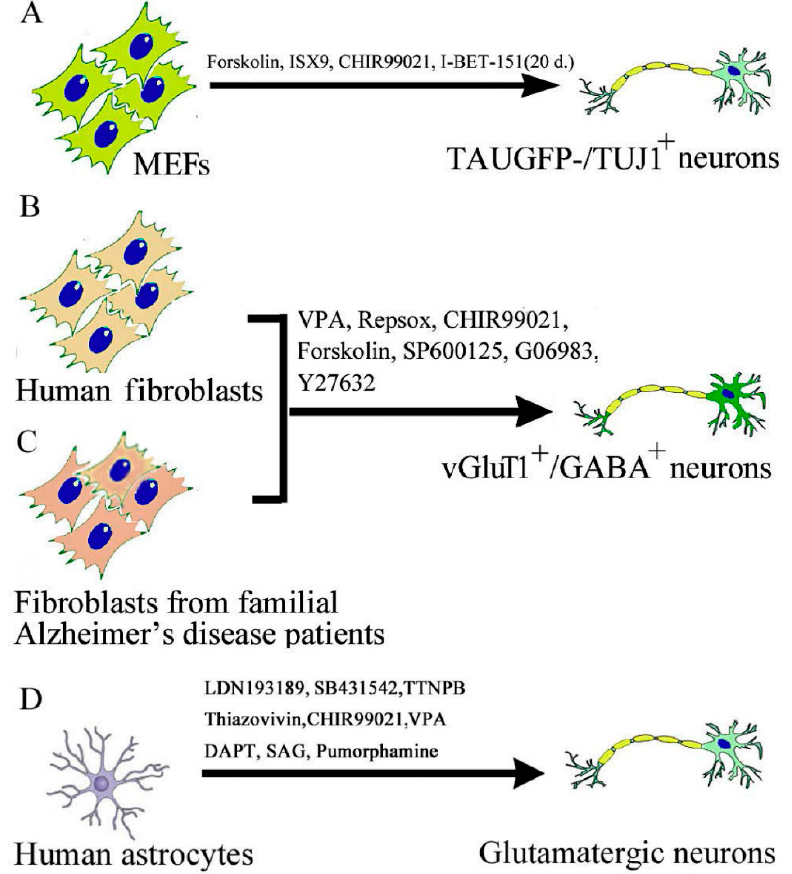
Figure 2. Chemically induced reprogramming of ciN. ( A ) A schematic diagram showing direct reprogramming to neurons from MEF using the small-molecule cocktail. Initially, four small-molecule cocktail “FICS” (Forskolin, ISX9, CHIR99021, and SB431542) efficiently induced TAUEGFP-/TUJ1-positive immature neurons within 21 days. Later addition of I-BET151 dramatically enhanced the reprogramming rate (with a 90% TUJ1-positive cell yield) and more mature ciN; ( B ) Human fibroblasts were directly converted into functional GABAergic and glutamatergic neuronal cells by a chemical cocktail VCRFSGY (valproic acid; CHIR99021; Repsox; SP600125 (JNK inhibitor), GO6983 (PKC inhibitor) and Y-27632 (ROCK inhibitor)), bypassing a neural progenitor stage; ( C ) This approach was further applied to generate hciNs from familial Alzheimer’s disease patients’ fibroblasts; ( D ) Human astrocytes were directly converted into functional GABAergic neurons by LDN193189, SB431542, TTNPB, Thiazovivin, CHIR99021, VPA, N -[ N -(3,5-difluorophenacetyl)- L -alanyl]- S -phenylglycine t-butyl ester (DAPT), Smoothened agonist (SAG), and purmorphamine.